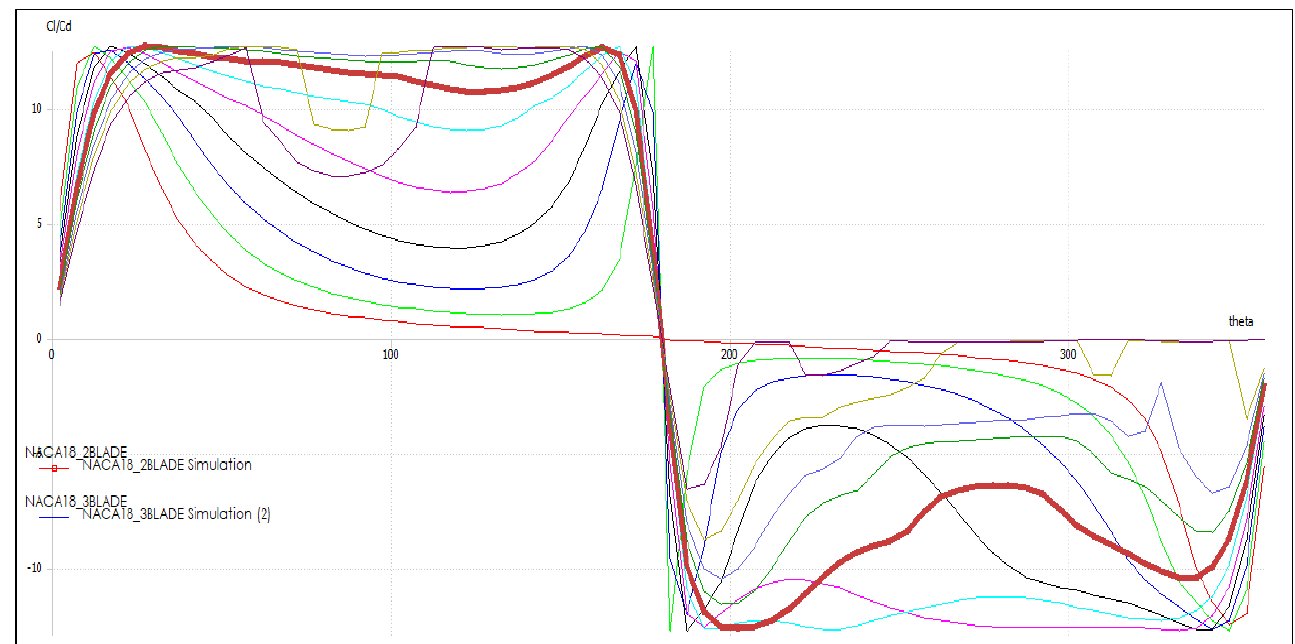
Figure 33. Cl/Cd vs theta plot of mid-section for TSR 4